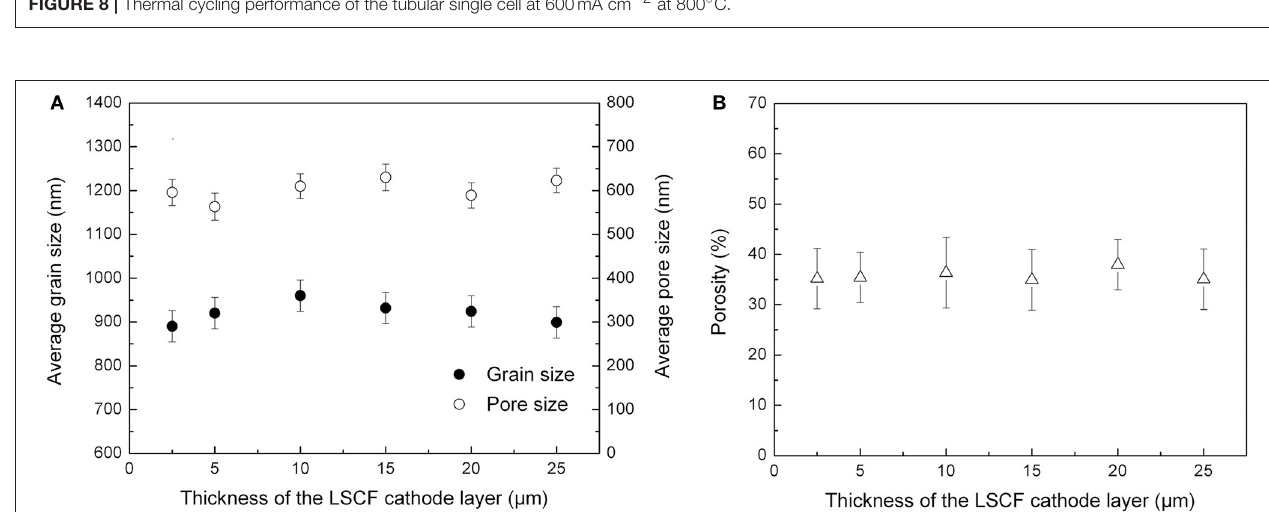
FIGURE 8 | Thermal cycling performance of the tubular single cell at 600mA cm − 2 at 800 ◦ C.